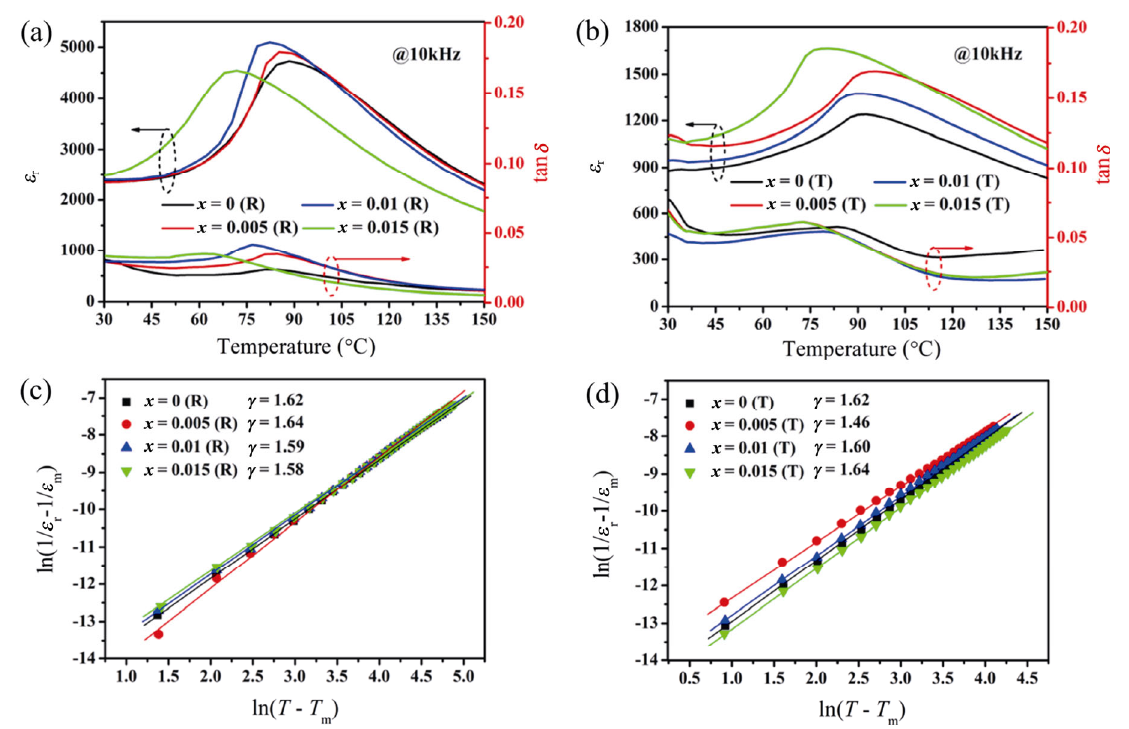
Fig. 6 (a, b) Temperature dependences of ε r and tan δ of randomly oriented and textured x Er–BCTZ thick films; (c, d) ln(1/ ε r – 1/ ε m ) as a function of ln( T – T m ). T C of randomly oriented and